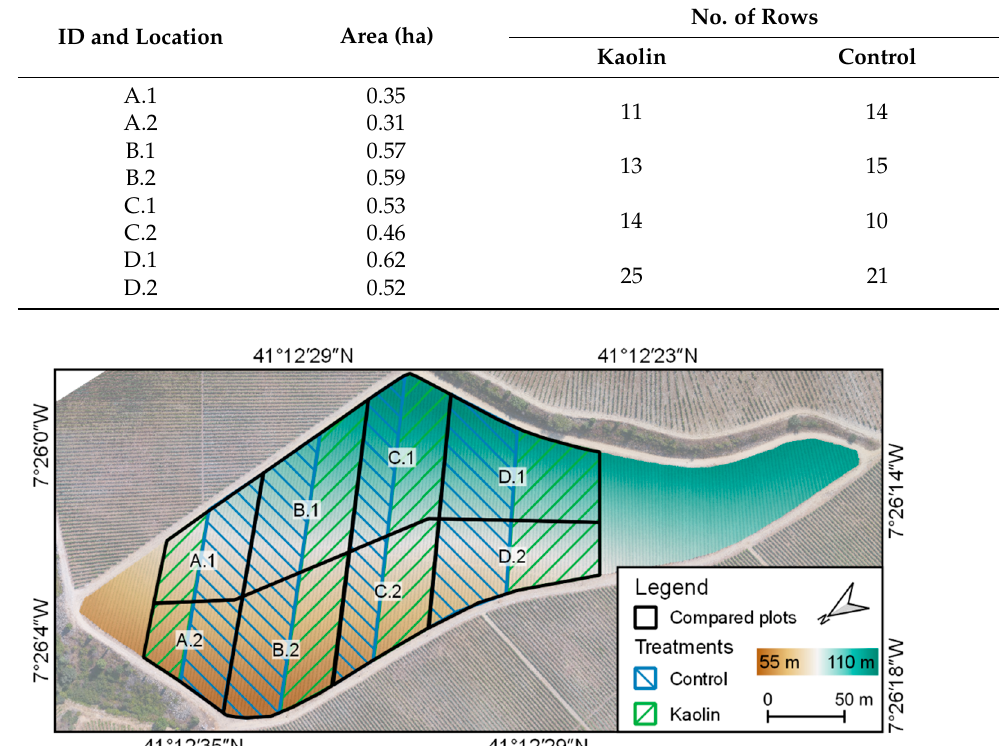
Figure 3. Delimitation and identification of the compared treatment plots and the vineyard digital terrain model. Orthophoto mosaic from the first flight campaign as